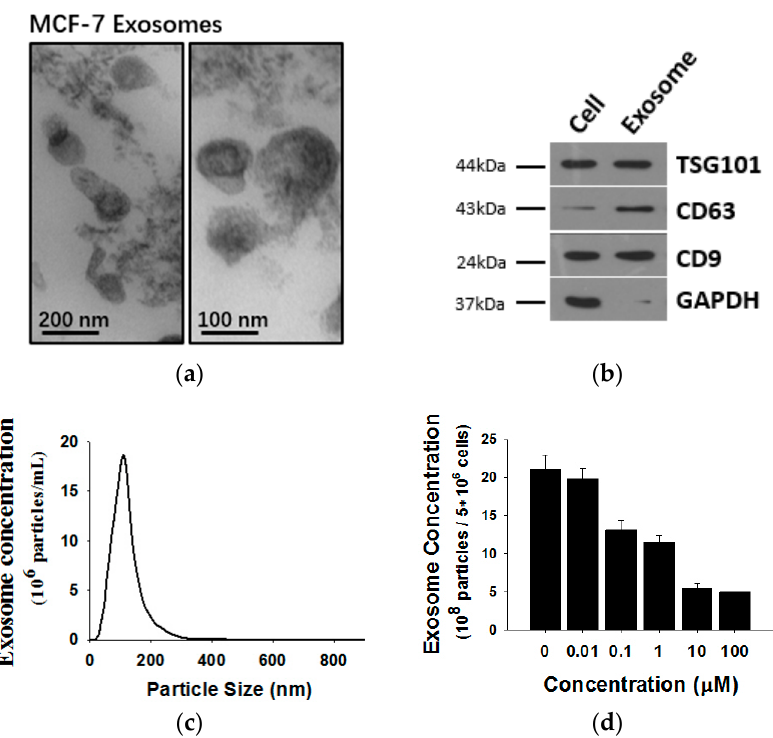
Figure 2. ( a ) Analysis of exosomes released by MCF-7 cells by transmission electron microscopy (TEM); ( b ) western blotting and; ( c ) Nanoparticle Tracking Analysis (NTA); ( d ) It should be noted that exosomes are approximately 100 nm vesicles with a double membrane structure and express marker membrane proteins such as Tsg101, CD63 and CD9. Shikonin decreases exosome release in a dose-dependent manner.